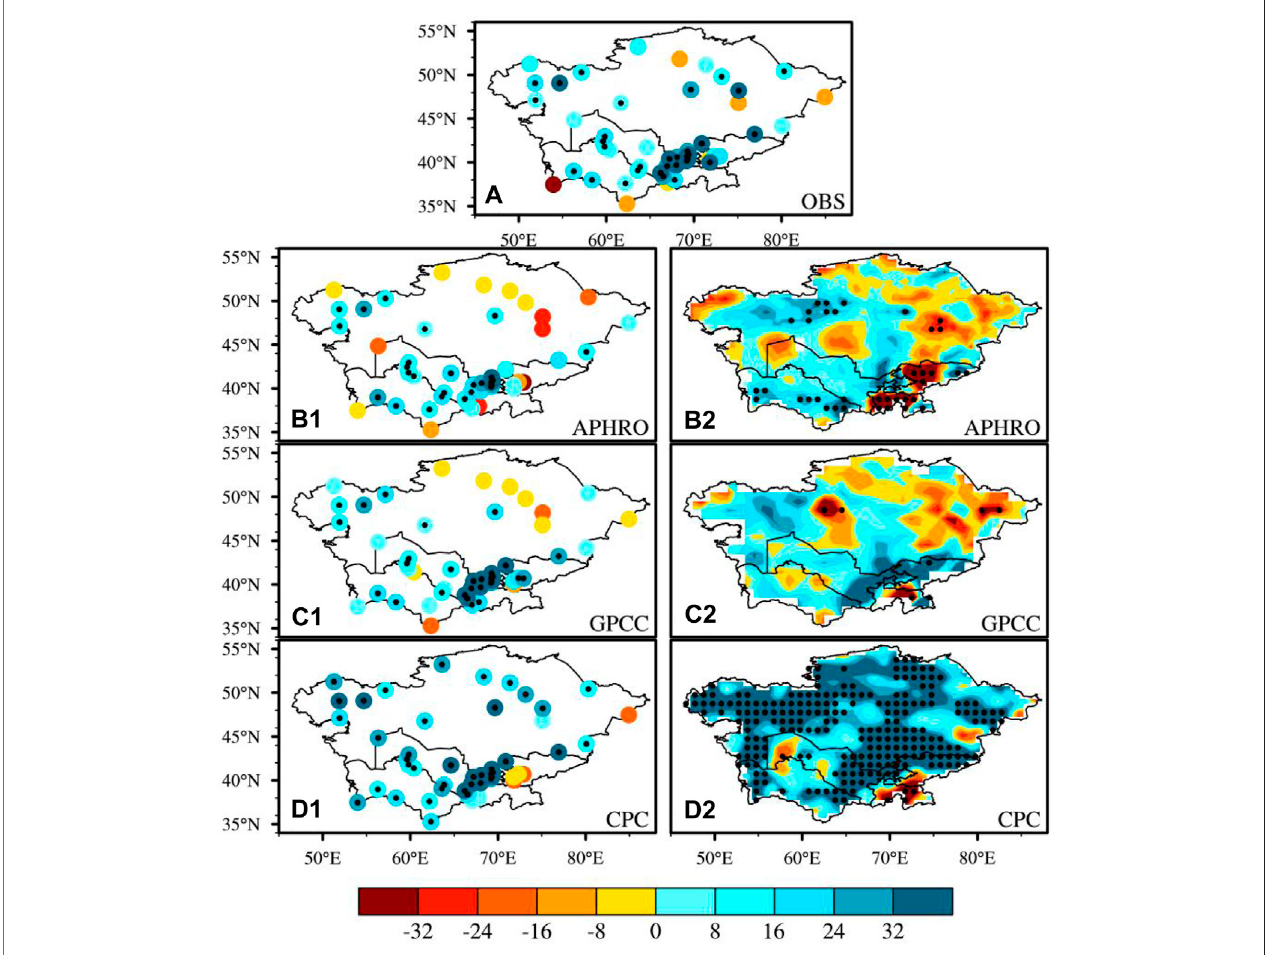
FIGURE 11 | Spatial distribution of the annual precipitation trend of OBS (A) , APHRODITE (B1) , GPCC (C1) and CPC (D1) over the CA from 1985 to 2005 (the black dots represent trends were signi fi cant at the 0.05 level ).